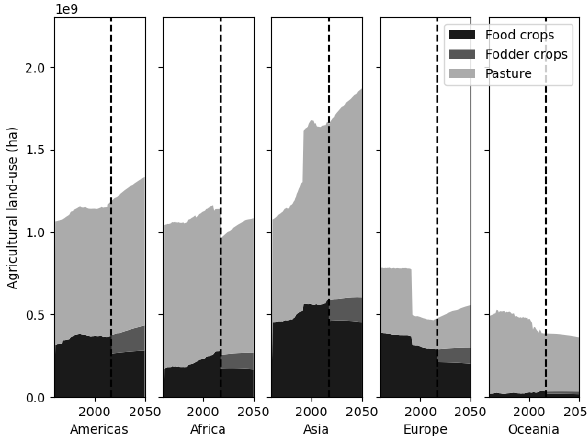
Figure 2. Agricultural land use in FAOSTAT historical data and the C-LLAMA anchor scenario projection for five continental re- gions. The transition from historical to modelled data is denoted by the dotted black line. Discontinuity at the dotted line is due to the countries not included in C-LLAMA for various reasons described in Sect. 3. 99. A total of 7% of this discrepancy is the result of unavailable food balance data for Libya, Somalia, Sudan, the DRC, and Papua New Guinea. Also note the sudden increase in land use in Asia and corresponding decrease in Europe in the early 90s, which is the result of the dissolution of the Soviet Union. As the FAO- STAT land use does not contain disaggregated crop data for fodder and food, food crops also include fodder crops in the historical